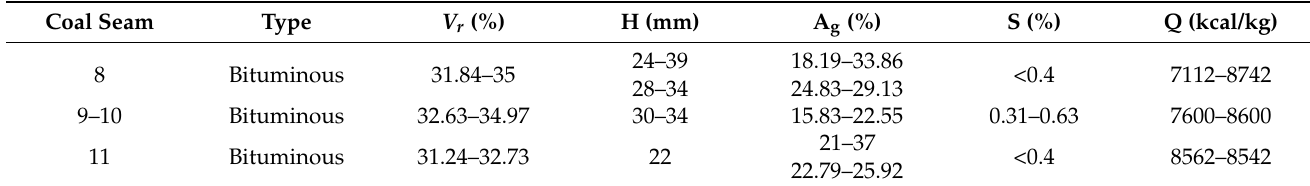
Table 3. Proximate analysis and coal type of group coal.